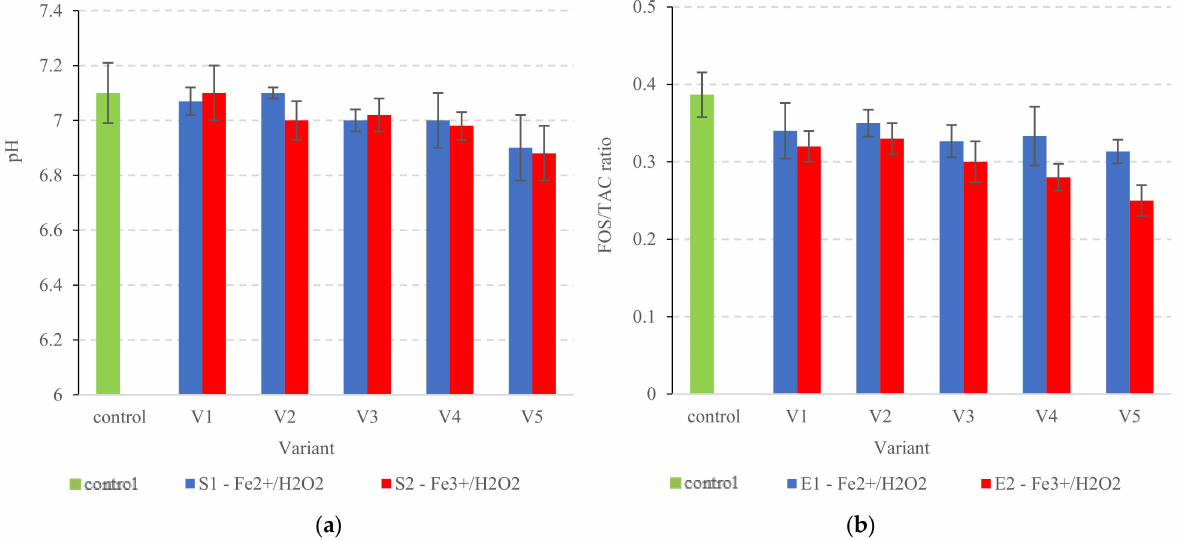
Figure 10. ( a ) The pH, ( b ) FOS/TAC of the digested PSS after